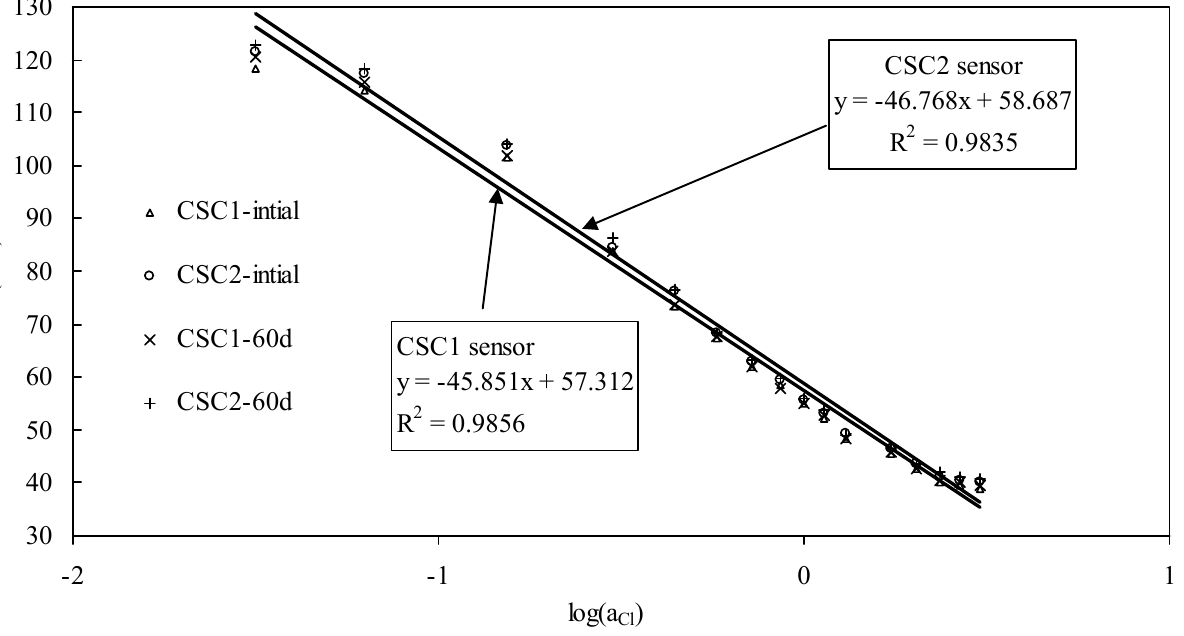
Figure 2. Potentiometric response of the sensor to chloride